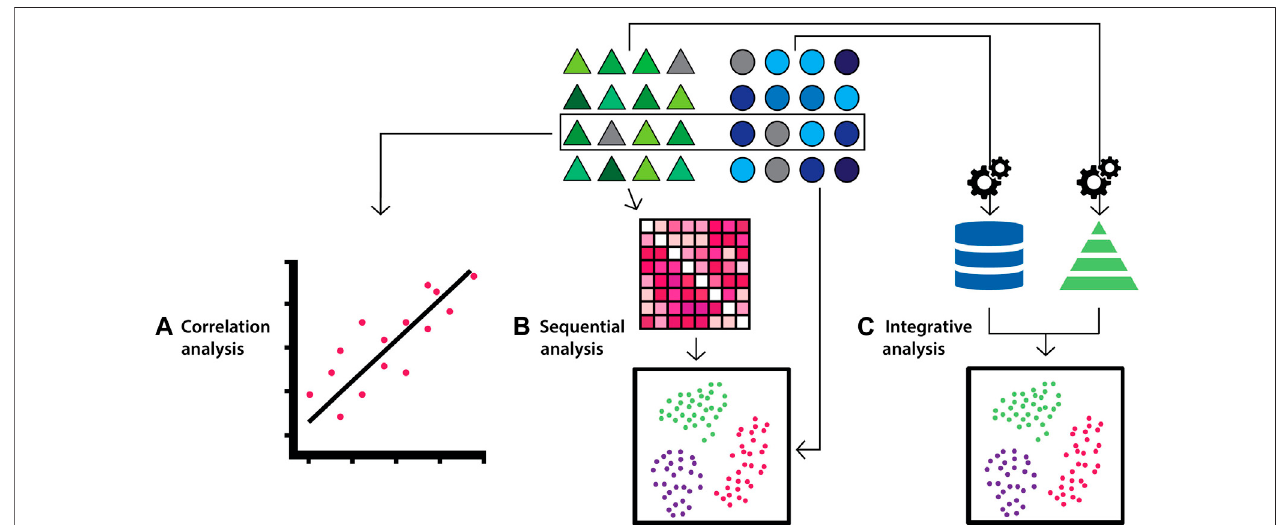
FIGURE2| Diagramdepictingmulti-modaldataintegrationstrategiesaccordingtothecorrelation,sequentialandintegrativecategorisations.Triangles(green)and circles (blue) represent datasets from distinct biological data modalities. (A) For correlation-based integration strategies, distinct data modalities are processed and analysed independently, and correlations between the data are identi fi ed from the results. (B) In sequential integration strategies the results of the analysis on one data modality arere fi ned by theintegrationofadditional data modalities in subsequent analyses. (C) In theintegrativeanalysisapproach, each datamodalityundergoes feature transformation independently, which are subsequently combined and analysed.